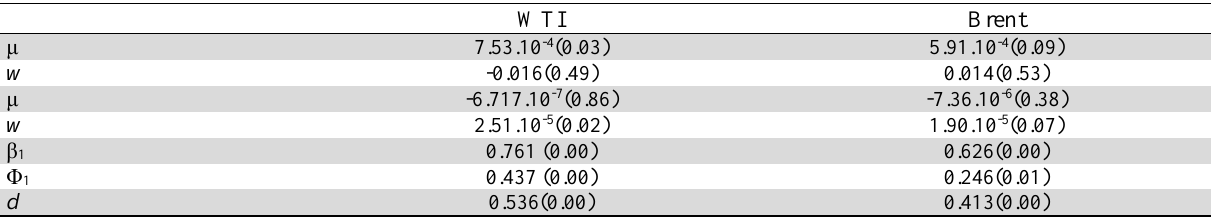
Estimation results of FIGARCH models